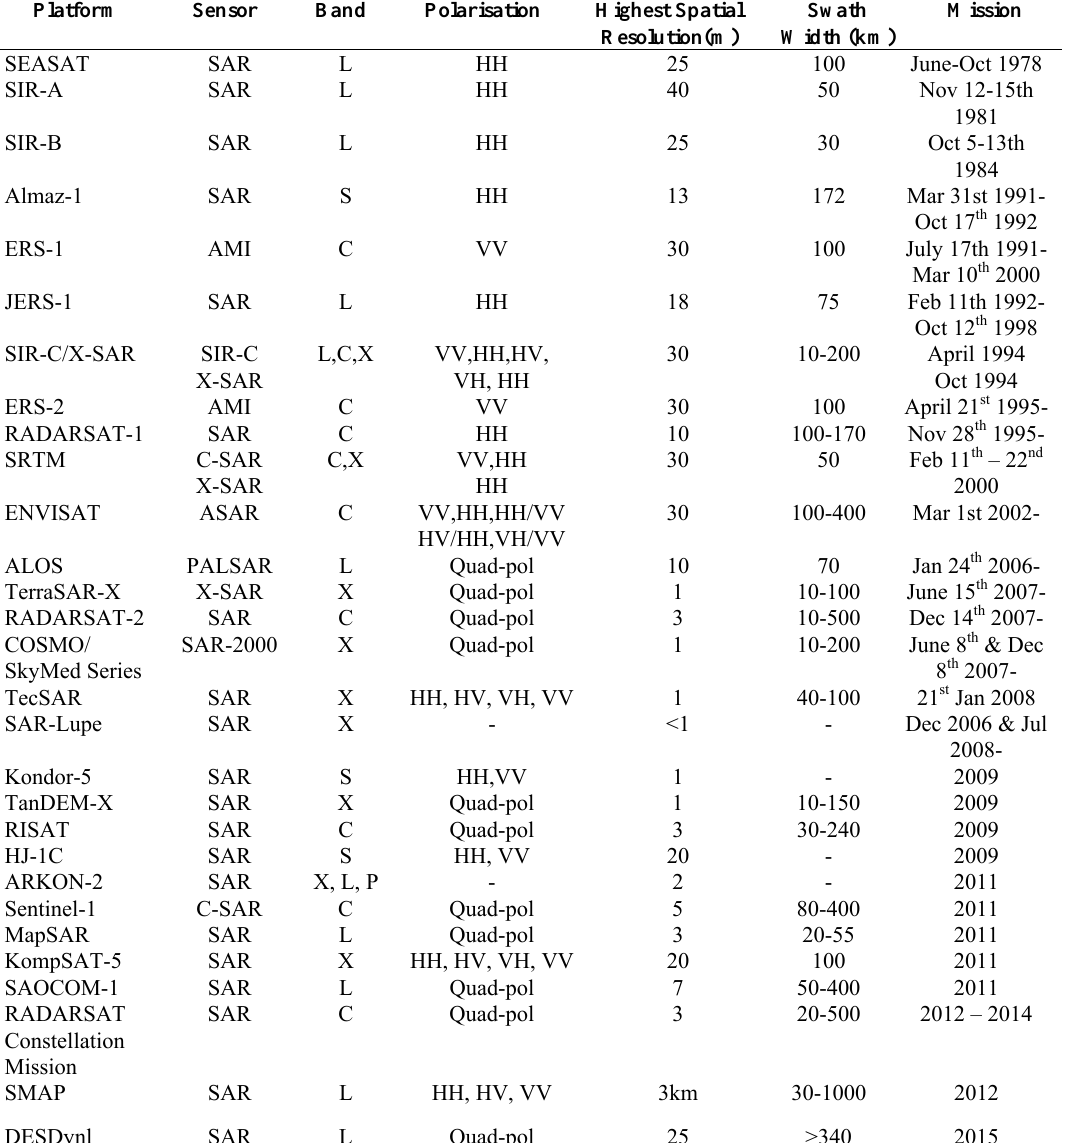
Table 1. Characteristics of major spaceborne SAR